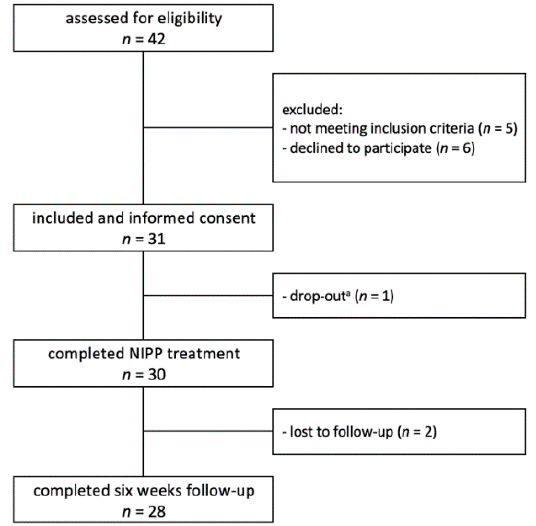
Figure 2. Flowchart of patient selection. NIPP = non-invasive physical plasma. a Interruption of radiation treatment for 7 days due to community-acquired pneumonia. Table 2. Summary of patient and treatment characteristics ( n = 30).